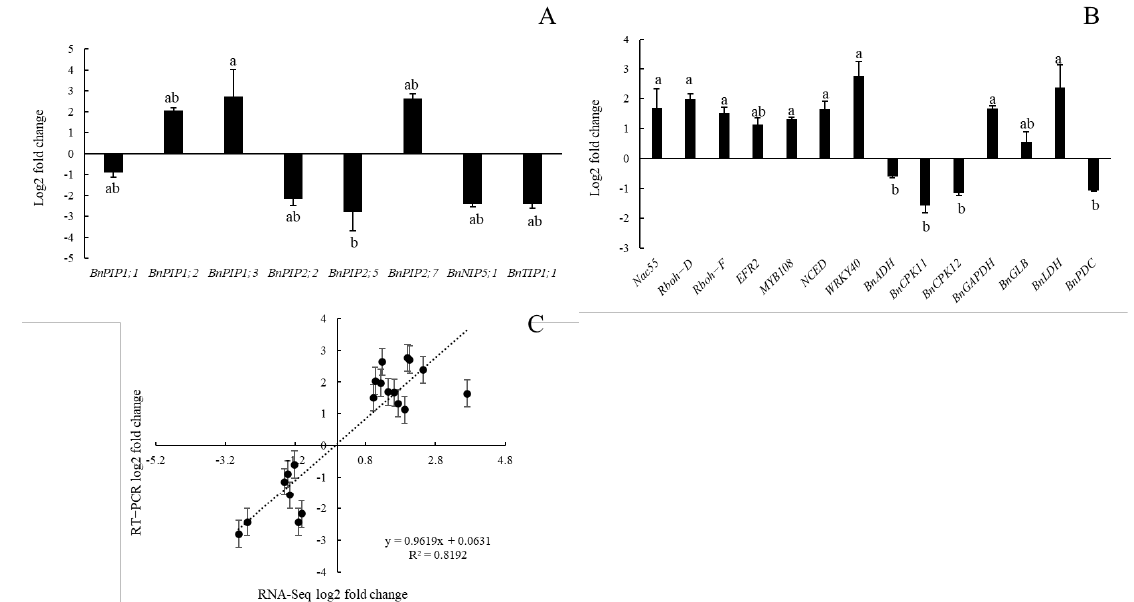
Figure 7. Validation of RNA-seq results through qRT-PCR analysis. ( A , B ) Fold change of differentially expressed genes through qPCR method. ( C ) Correlation analysis of differentially expressed genes between qPCR analysis and RNA-seq experiment. Different letters indicate statistically significant differences between different genes ( Tukey’s test; p ≤ 0.05 ; one-way ANOVA).